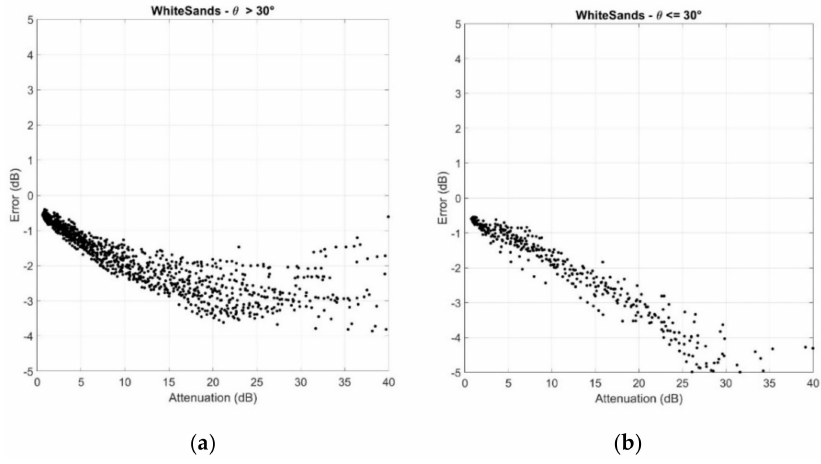
Figure A7. Scatter plots of the error ε = A SST , glo − A SST versus A SST : ( a ) θ > 30 ◦ ; ( b ) θ ≤ 30 ◦ . White Sands.